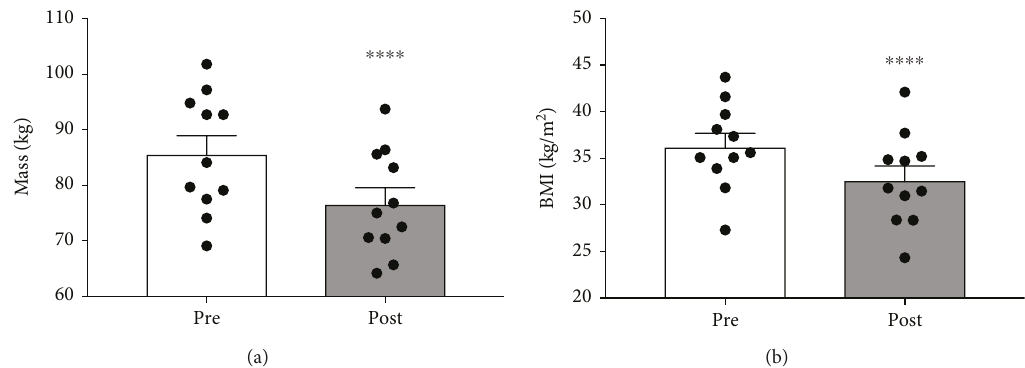
Figure 1: The e ff ect of a 90-day low-carbohydrate diet on body weight (a) and BMI (b) in women ( n = 11 ; ∗∗ p < 0 0001 ).